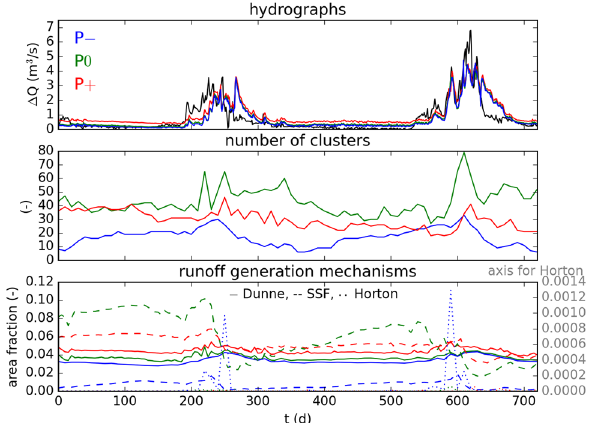
Figure 5. Top: Model discharge predictions at PH for different model variations with the boundary condition subtracted to visualize isolated processes within the catchment. The observed discharge at PH is plotted with a black continuous line. Middle: Number of disconnected wet clusters. Bottom: Runoff generation mechanism dynamics in the catchment. The figure plots the fraction of the catchment area that showcases a certain runoff generation mechanism over time.